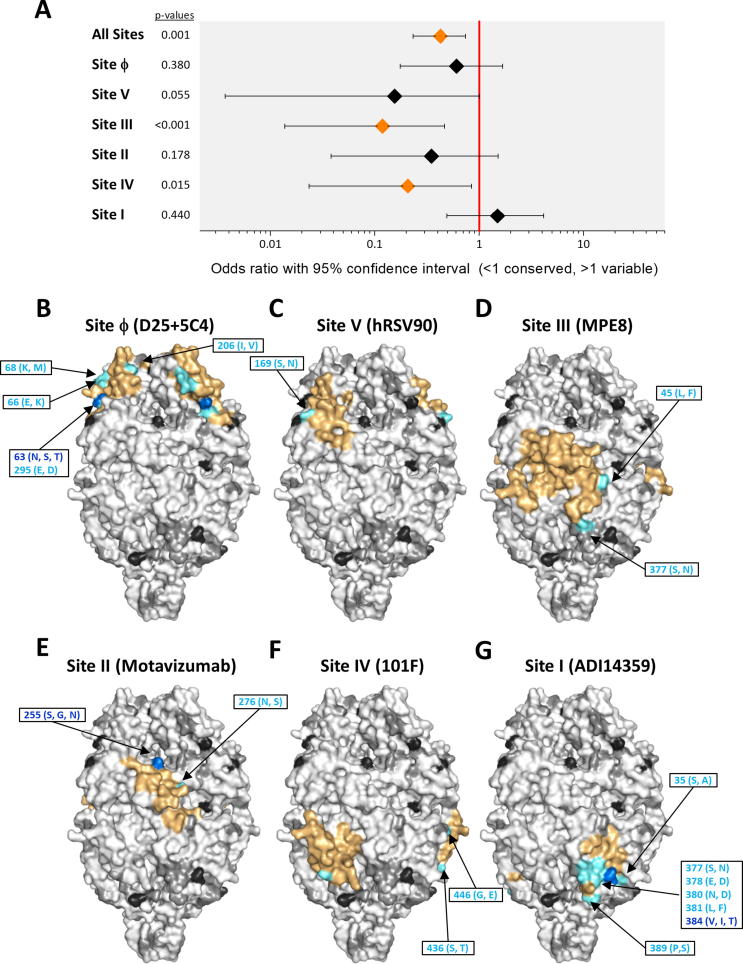
Location of amino acid differences between A2 and group A strains on the structure of prefusion hRSV F. (A) Fisher’s exact tests are shown for the probability of a mutation occurring inside or outside an antigenic site. For each antigenic site and for all antigenic sites grouped together (“All sites”), data are presented as an odds ratio with a 95% confidence interval. Significantly (p < 0.05) increased or reduced values are displayed in blue and orange, respectively, with non-significant odds ratios shown in black. (B–G) The surface of the prefusion F trimer is shown in each panel with the indicated antigenic site delineated in color as identified in Fig. 2. Within each antigenic the amino acids are colour based on the number of changes in a given residue: no variants in orange, 1 variant in cyan, 2 variants in blue and 3 variants in red. Amino acid changes included in each antigenic site are denoted in the different panels. When the number of amino acid changes prevented showing them individually, the changes were included in a box, as for instance in antigenic site I (panel G). The changes are listed in Supplementary Table S1. Amino acid outside the antigenic site are shown in increasing intensities of grey and black, where white indicates sequence conservation. (For interpretation of the references to color in this figure legend, the reader is referred to the web version of this article.)